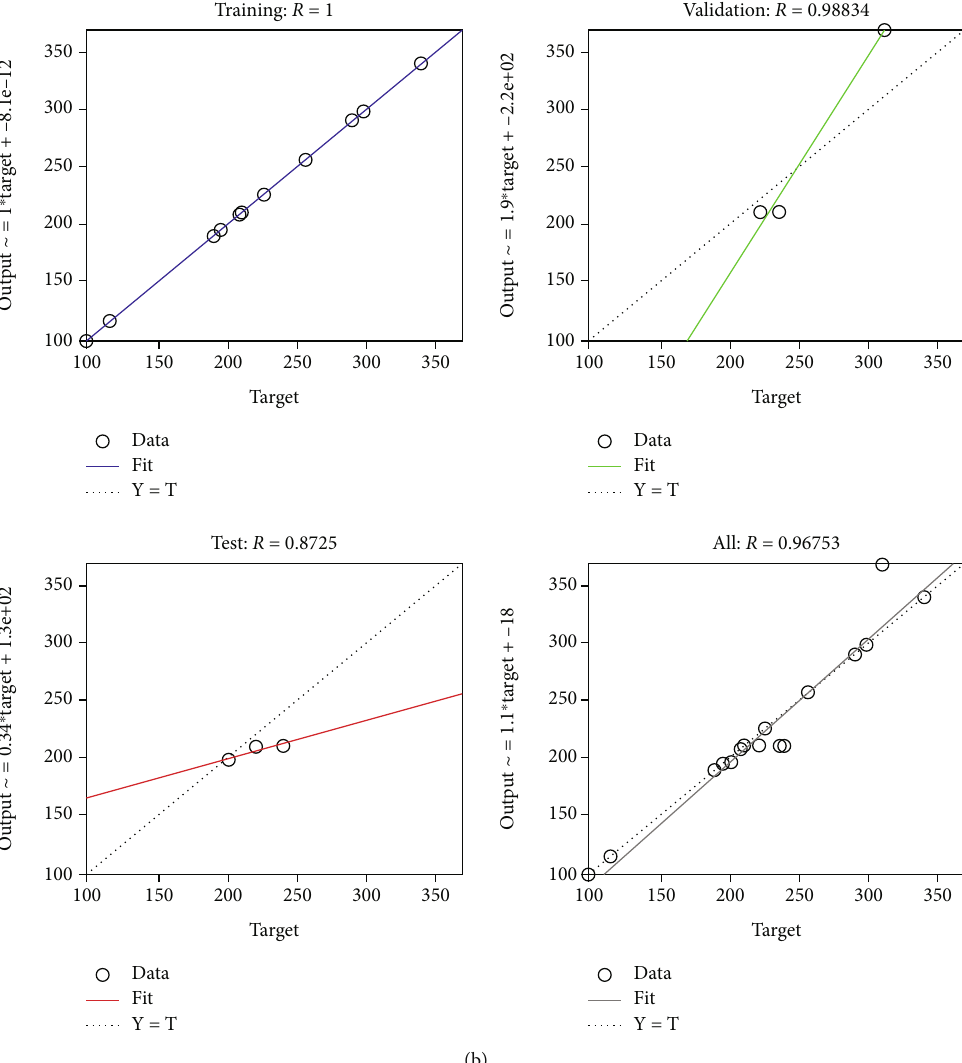
Figure 5: ANN performance features of (a) iodine number and (b) methylene